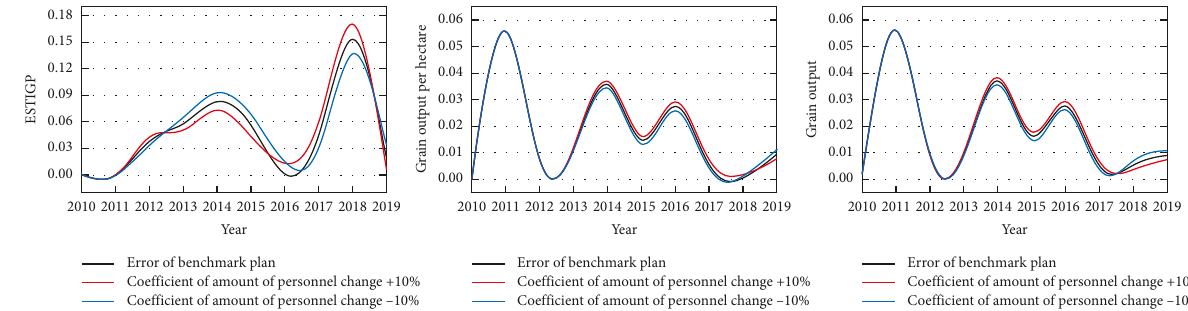
Figure 4: Error trend diagram of adjustment of amount of change of